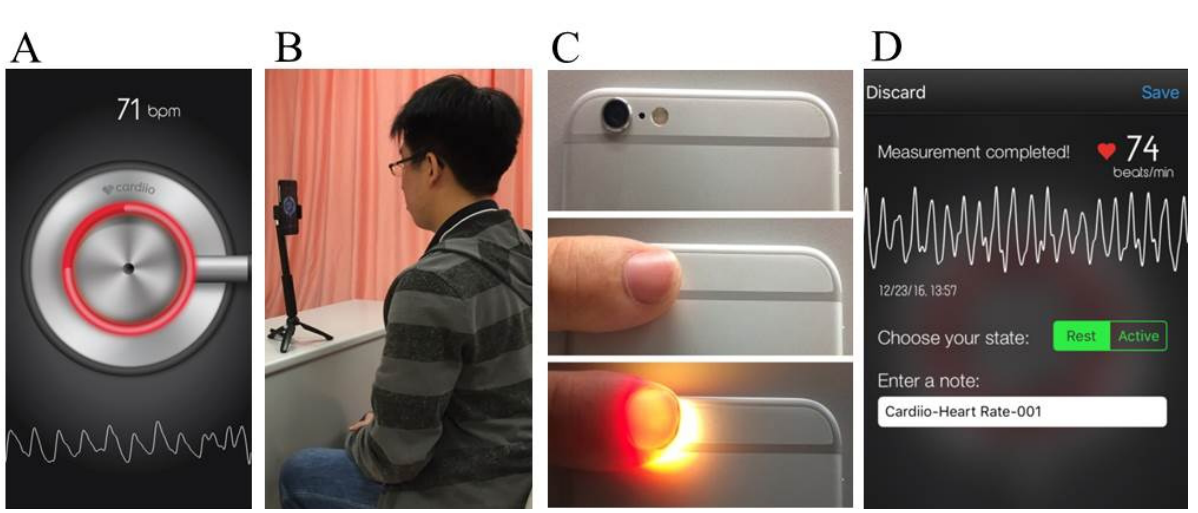
Figure 1. (A) Cardiio smartphone app. (B) Setup to acquire photoplethysmographic (PPG) signals from the participant's face. (C) Obtaining PPG signals from the fingertip. (D) Example of a report produced by the Cardiio smartphone